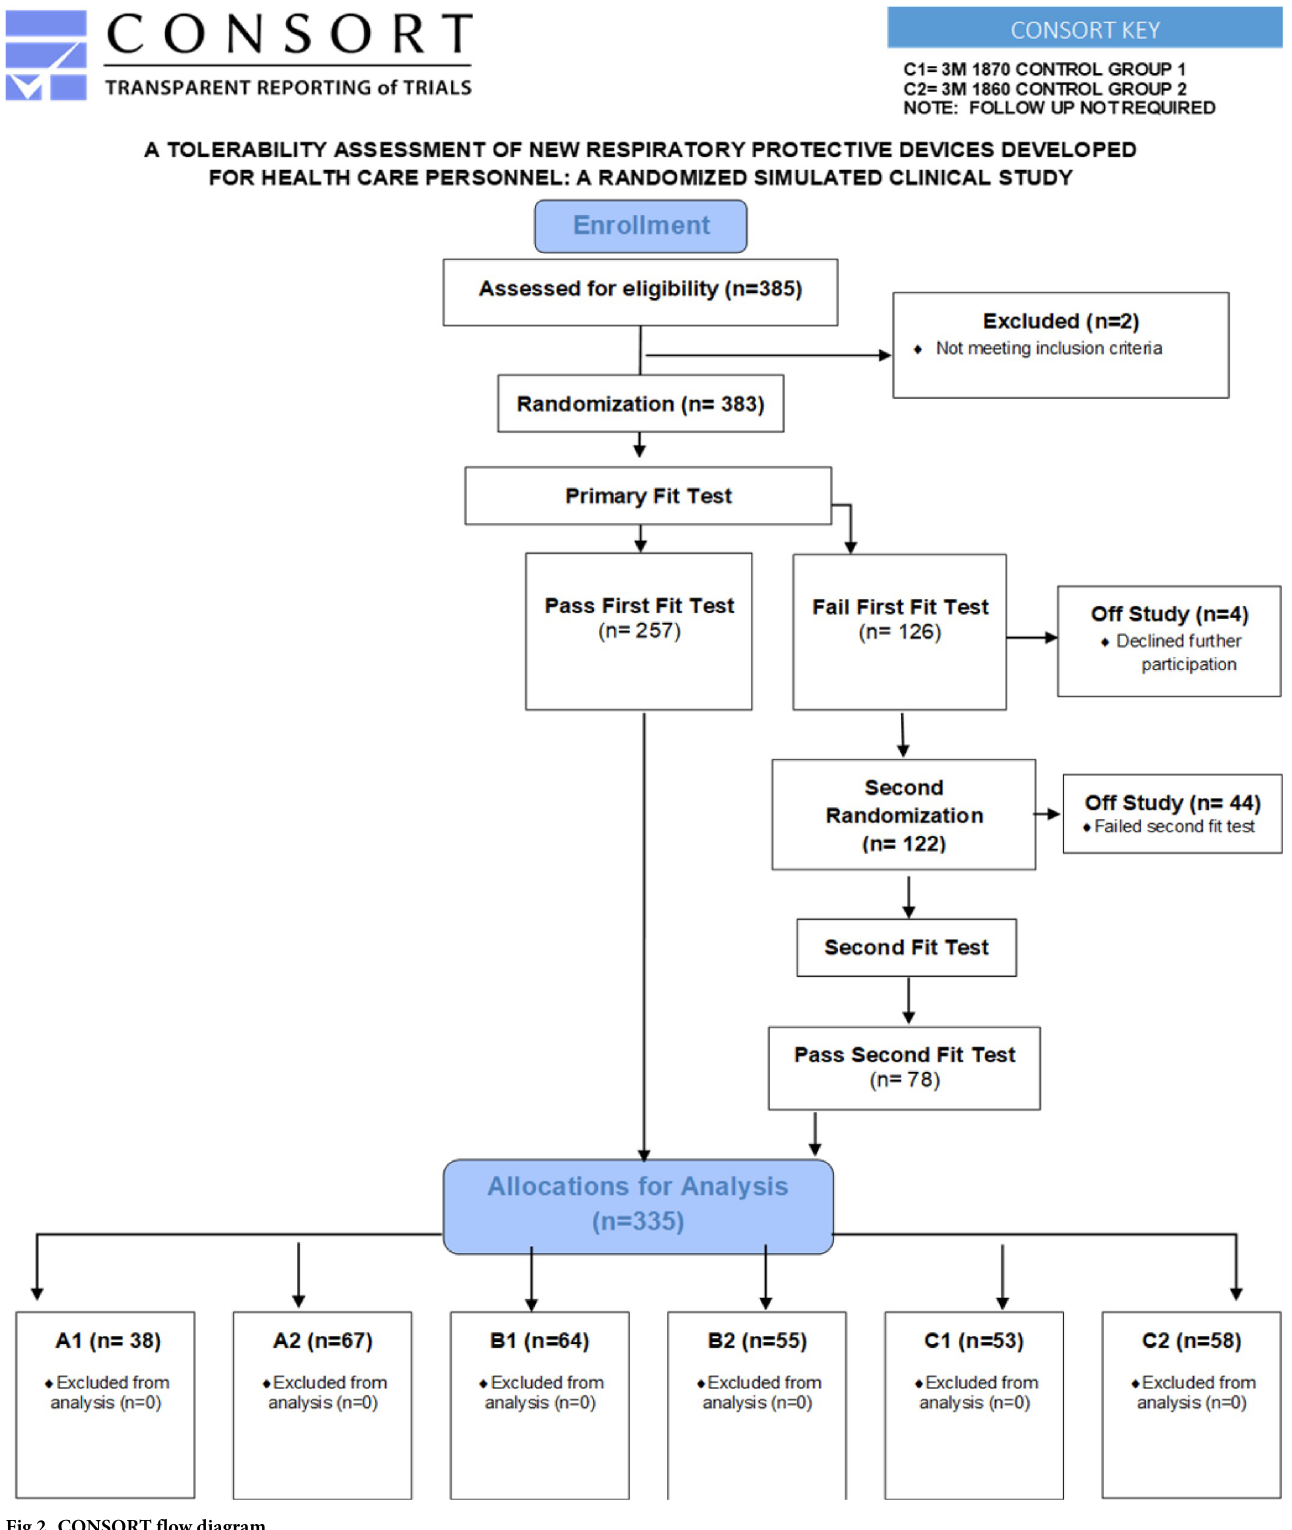
Fig 2. CONSORT flow diagram.